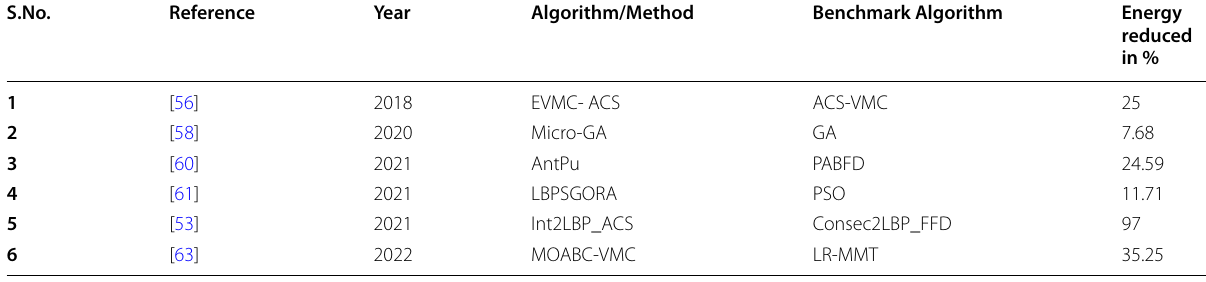
Table 4 Comparison of benchmark concerning Energy Consumption for Table 3 S.No.